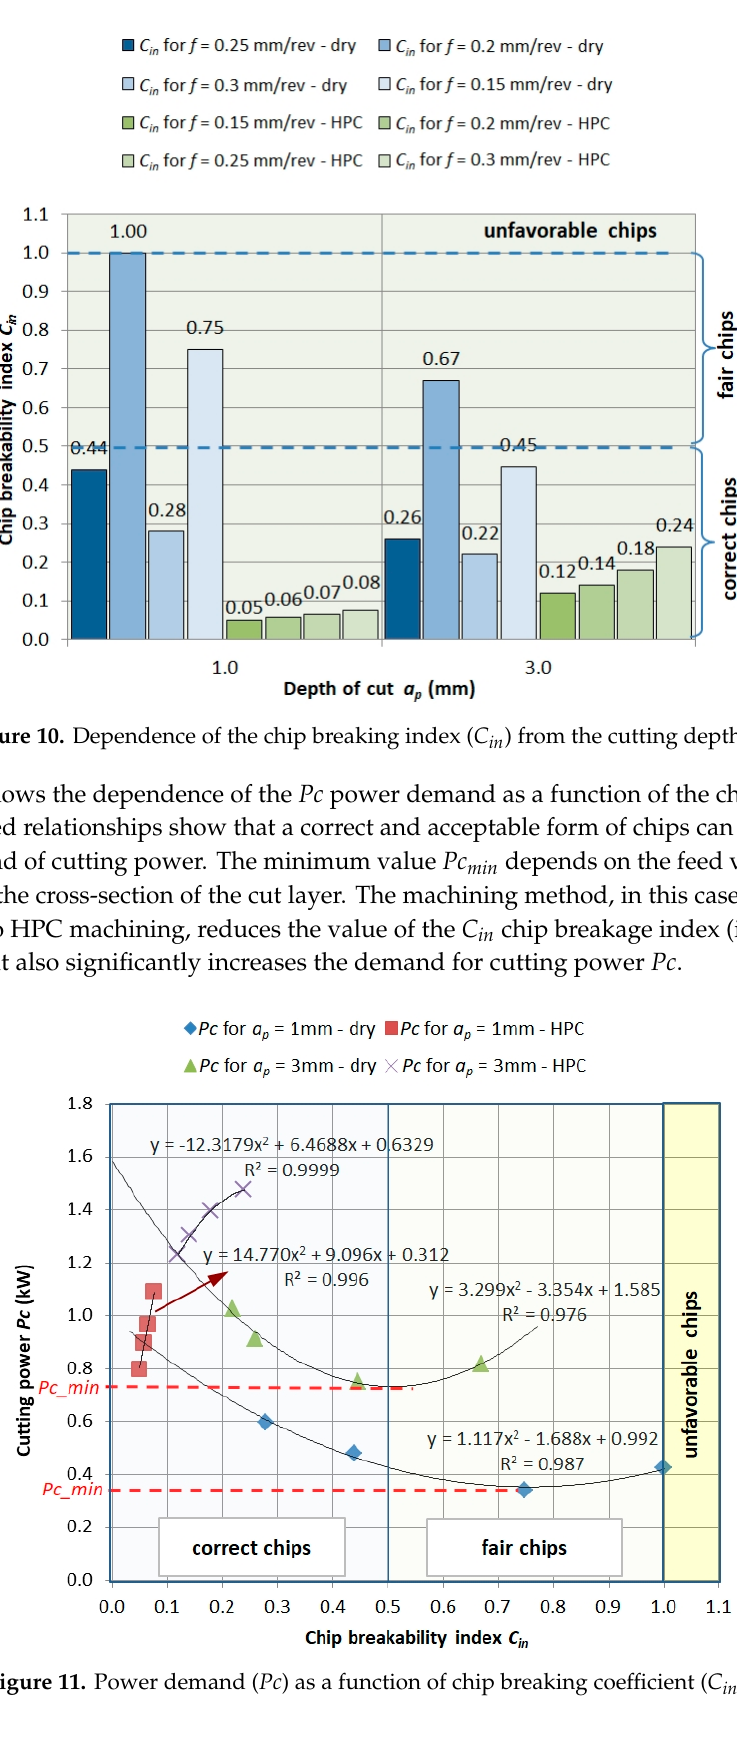
Figure 11. Power demand ( Pc ) as a function of chip breaking coefficient ( C in ).